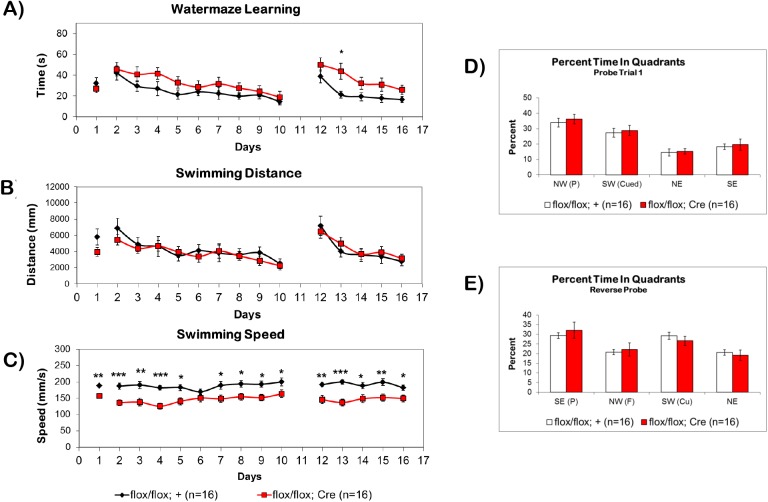
Spatial Learning and Memory in the MWM is Not Affected by Loss of BMPRII.(A) fbΔBMPRII mutant mice (red) do not have a significantly different learning curve than control littermates (black) during the cued (1) or first hidden (2–10) phases of the water maze, but show a slower learning curve during the reversal (12–16) phase of the water maze. (B) The swimming distance of the mice was not different than control littermates, (C) but the swimming speed of the mice was significantly slower on most days of the water maze. The appearance of a slower learning trend during the first hidden phase and reversal is likely an artifact of slow swimming speed rather than slower learning. (D-E) During probe trials fbΔBMPRII mutant mice show similar preference for the target quadrant as control littermates during both the first hidden phase and the reversal phase. Abbreviations: (P) platform position, (Cu) former cued platform position, (F) former hidden platform position. Results reported as mean ± S.E.M. Asterisk indicates *p<0.05, **p<0.005, ***p<0.0005, ****p<0.00005.